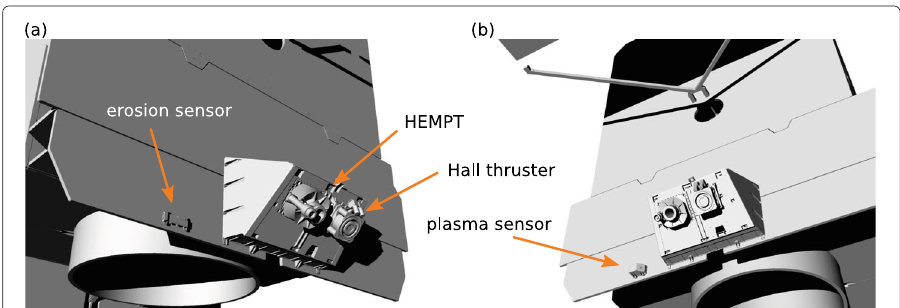
Fig. 2 The components of the Electric Propulsion Diagnostic Package (EPDP) on the satellite. (a) The erosion sensor is mounted on a radiator close to one of the thruster pairs; (b) The plasma sensor is mounted on the radiator on the opposite side of the satellite next to the other thruster pair; its retarding potential analyzer is oriented toward the plume. Note that both sensors are at comparable positions to the respective thrusters. The instrument control unit of the EPDP is accommodated on the rear side of the same radiator where the plasma sensor is located and therefore not visible in the drawing. The harnesses to the plasma sensor and the erosion sensor are not shown